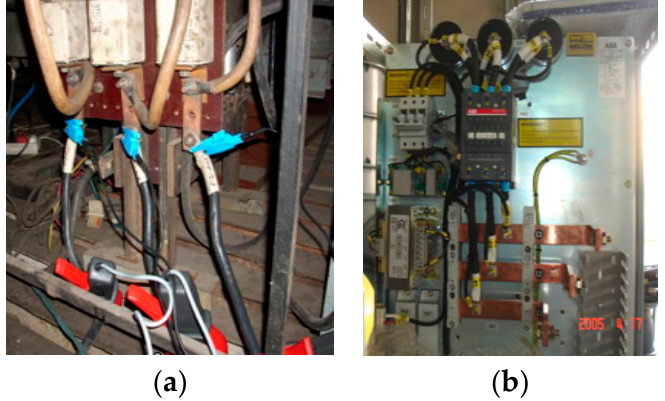
Figure 5. Electric connections to the secondary winding of the transformer ( a ); active filter type shunt, connected to the secondary winding of the transformer ( b ). Figure 6. A 150 kW D.C. motor ( a ); asynchronous generator ( b ); chopper used to supply the motor ( c ).